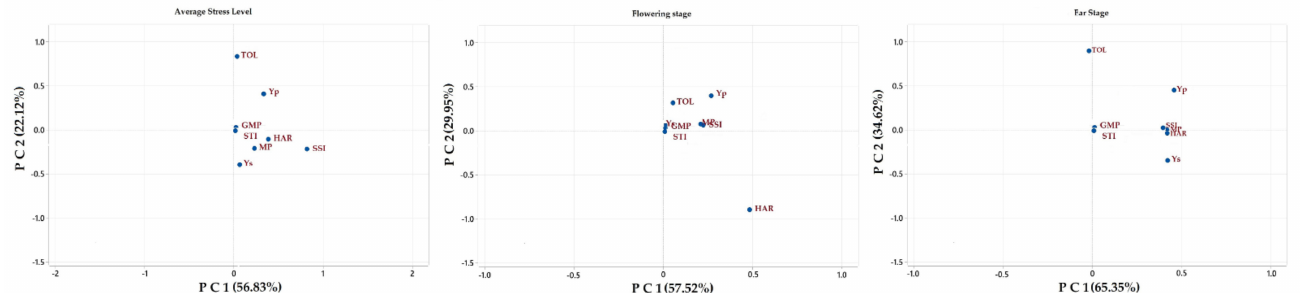
Figure 2. Principal component biplot on yield